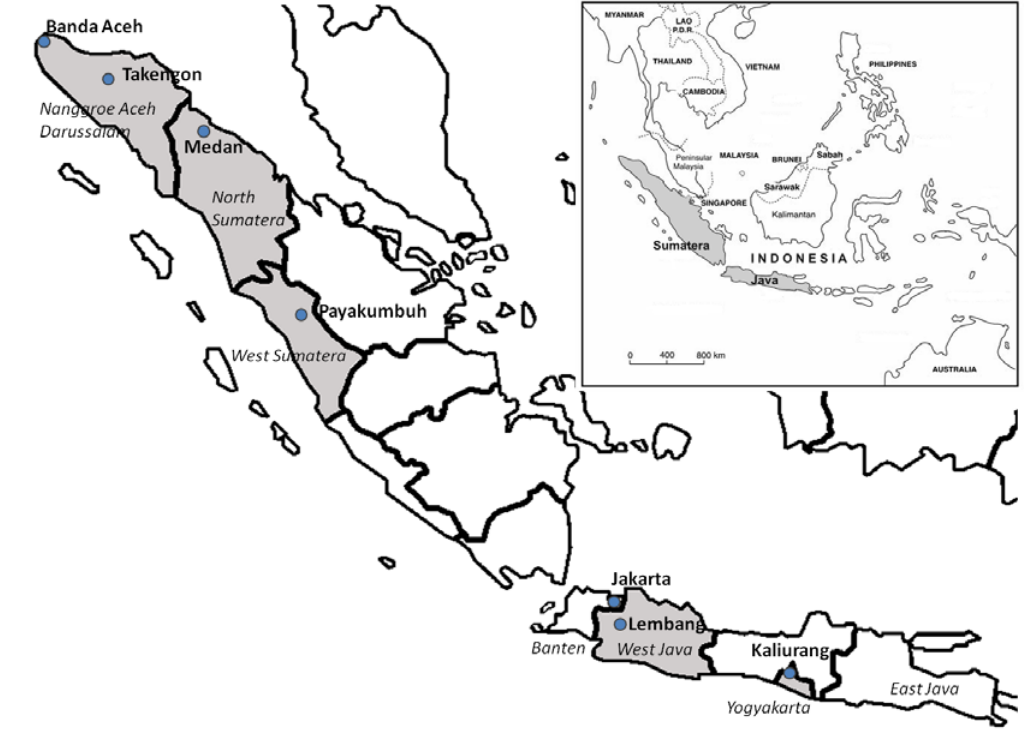
Figure 1. Map of the sample collection regions (blue dots) for Indonesian